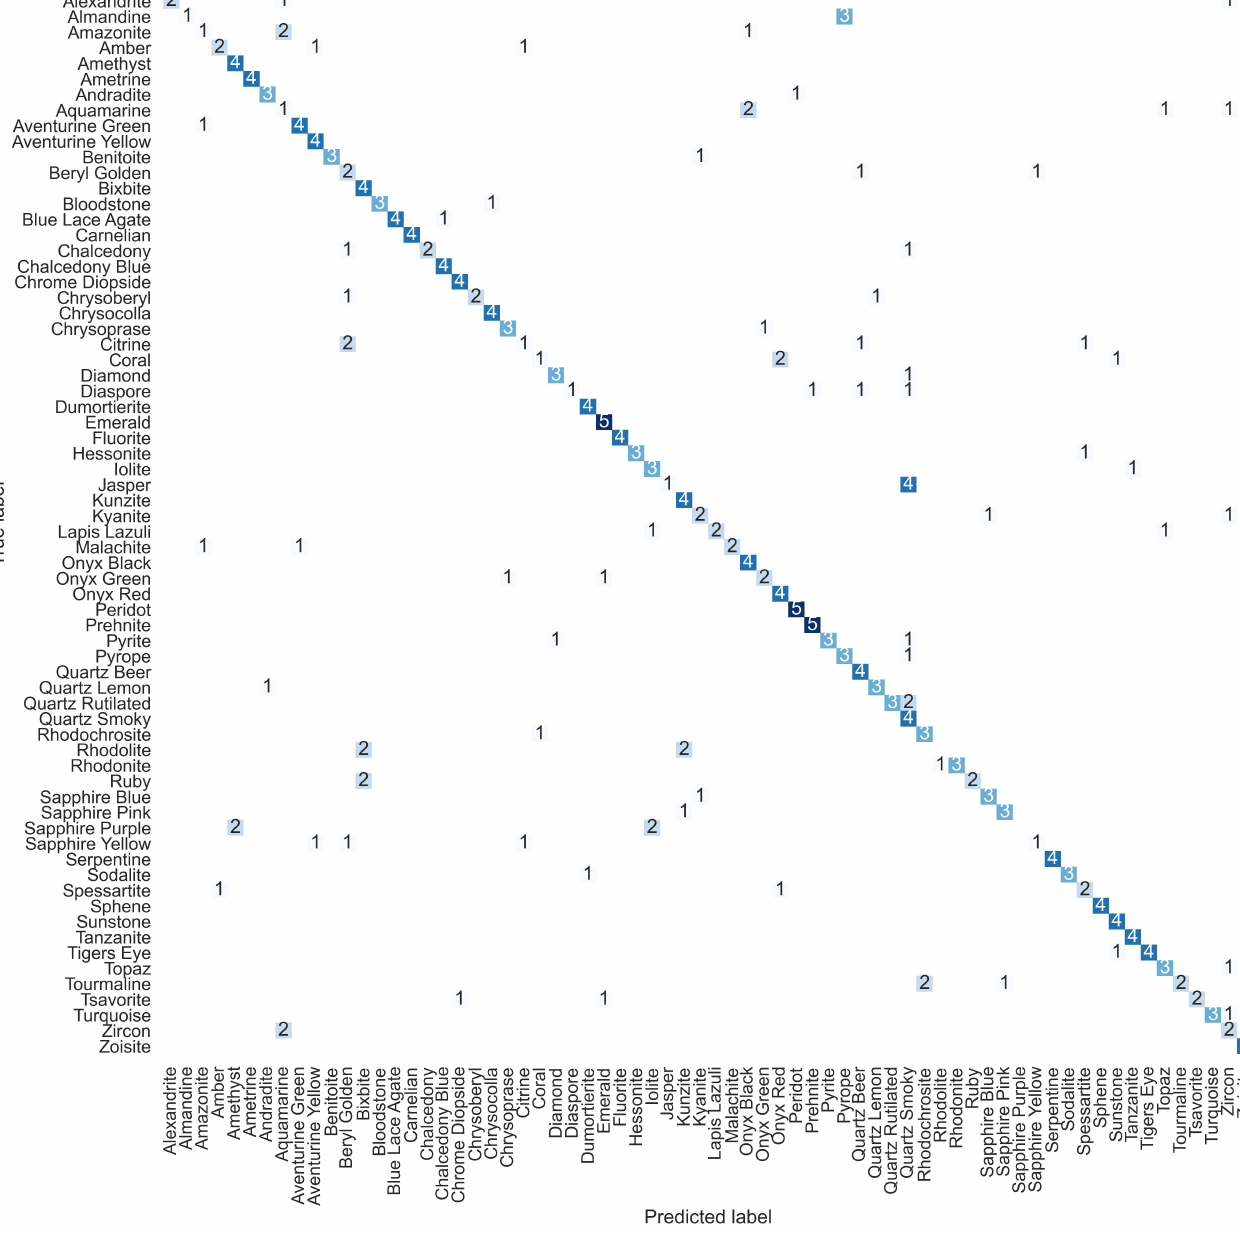
Figure 9. Confusion matrix of the most accurate combination, i.e., the Random Forest algorithm with the RGB 8-bin colour histogram and local binary pattern with 8 points at radius 1. The difficulty in separating between Jasper and Quartz Smoky and between Almandine and Pyrope should be